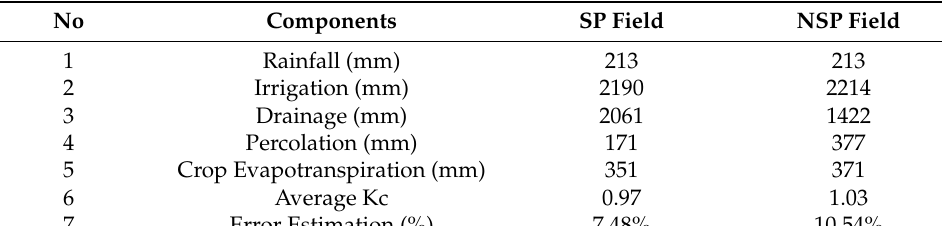
Figure 6. Actual water depth during the planting period in the sheet-pipe (SP) field and non sheet- pipe (NSP) field. Table 2. Water allocation in the SP field and NSP field.